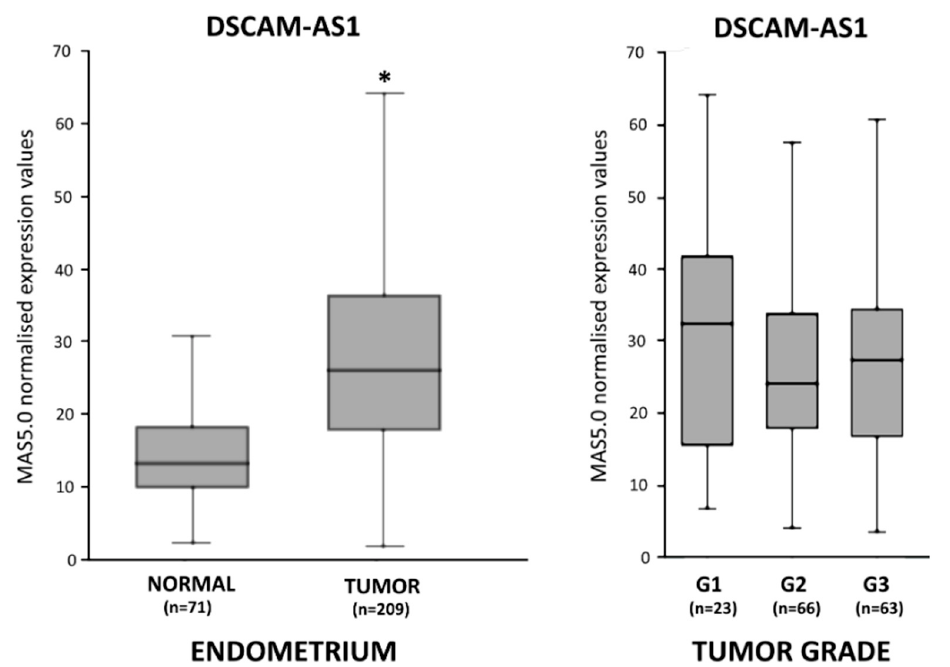
Figure 1. Expression of lncRNA DSCAM-AS1 in endometrial tissues as assessed by analysis of GEO open-source data using the online platform http://r2.amc.nl. Left panel: expression in normal endometrium ( n = 71) (GEO ID: GSE51981) and endometrial adenocarcinoma ( n = 209) (GEO ID: GSE2109). DSCAM-AS1 levels are shown as normalized expression values using the MAS5.0 method (Affymetrix). Right panel: expression in endometrial cancer grading subgroups G1, G2 and G3 (GEO ID: GSE2109). Shown graphs are box and whisker charts. Boxes represent the upper (Q3) and the lower quartile (Q1), and the line indicates the median of lncRNA expression values. The ends of the whisker are set as 1.5 × IQR above Q3 or below Q1. * = p < 0.01.